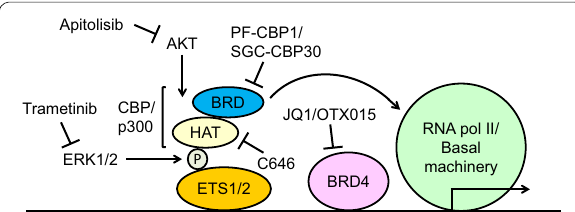
Fig. 3 ETS1/2 interacts with CBP/p300 to transactivate target genes. ERK1/2-phosphorylated ETS1 at Thr38 and Ser41, or ETS2 at Thr72 and Ser75, which enhances an association with two closely related transcriptional co-activating proteins, CBP and p300. The binding pro- motes the assembly of RNA polymerase II and the basal machinery at the initiation of transcription. AKT is likely to activate the ETS1/2-con- taining transcription factor-enhancer complex by phosphorylating CBP or p300, histone acetyltransferases (HAT) that possess bromodo- main (BRD). BRD4 is often co-localized with ETS1 and probably with ETS2 in transcription factor-enhancer complex. Thus, we may inhibit ETS1/2 activity by trametinib (MEK inhibitor), apitolisib (PI3K/mTOR inhibitor), C646 (CBP HAT inhibitor), PF-CBP1 or SGC-CBP30 (CBP BRD inhibitor), or JQ1 or OTX015 (BRD4